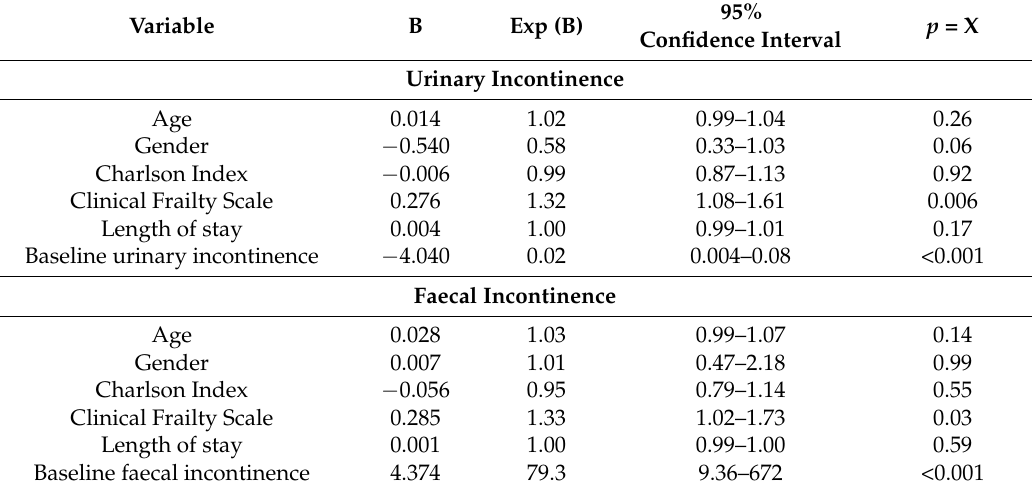
Table 4. Binary logistic regression model showing the association between variables and urinary and faecal